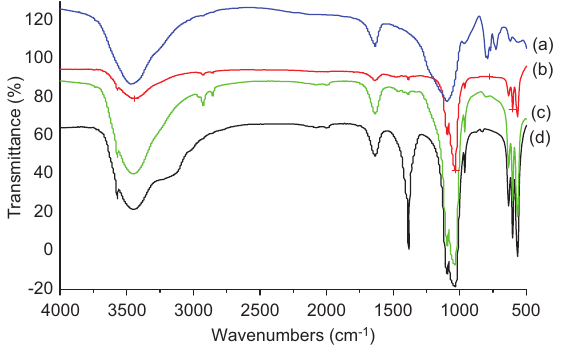
Figure 4 Comparison of FTIR spectra for silica-coated HAP. (A) Silica, (B) dodecyl alcohol treated HAP, (C) 50 wt % silica on HAP 050). (HAPS 050) and (D) i i